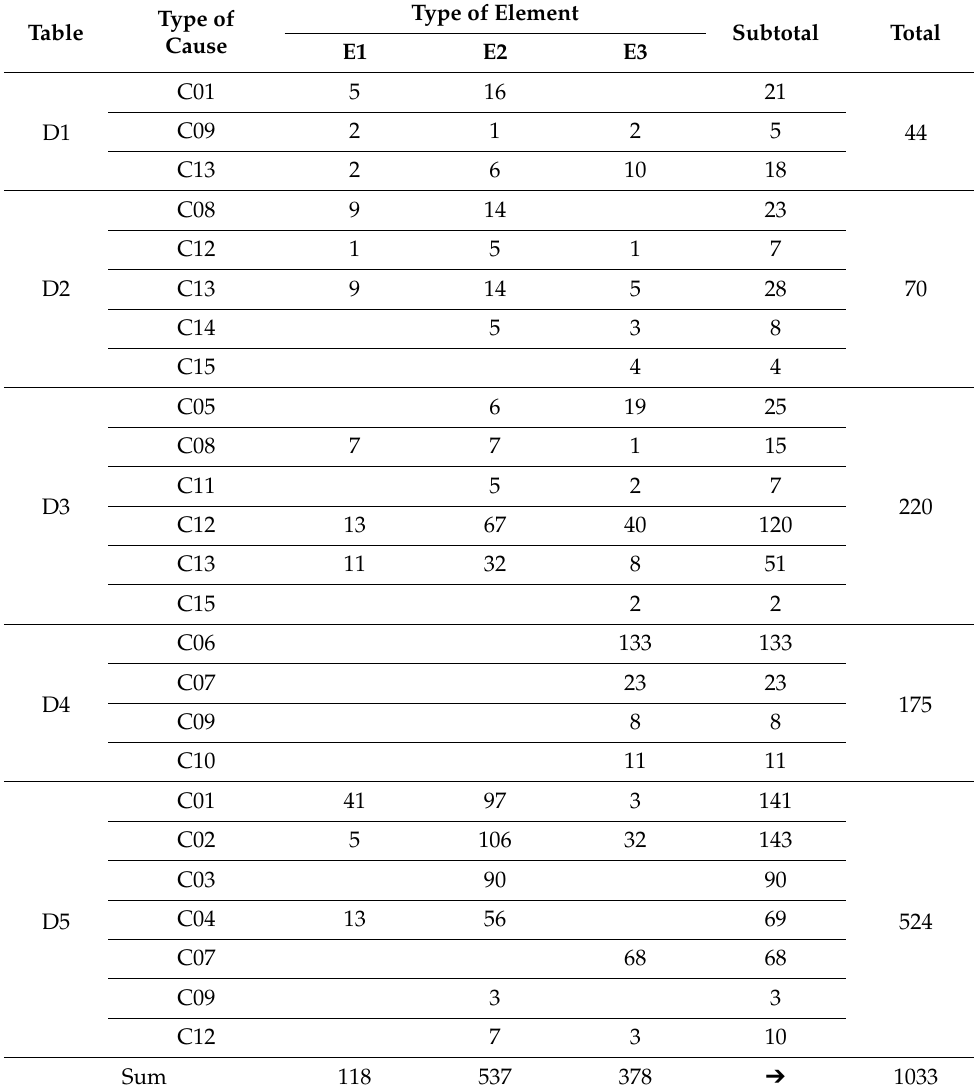
Table 7. Matrix of numerical relation between the between type of element, type of defect, and type of